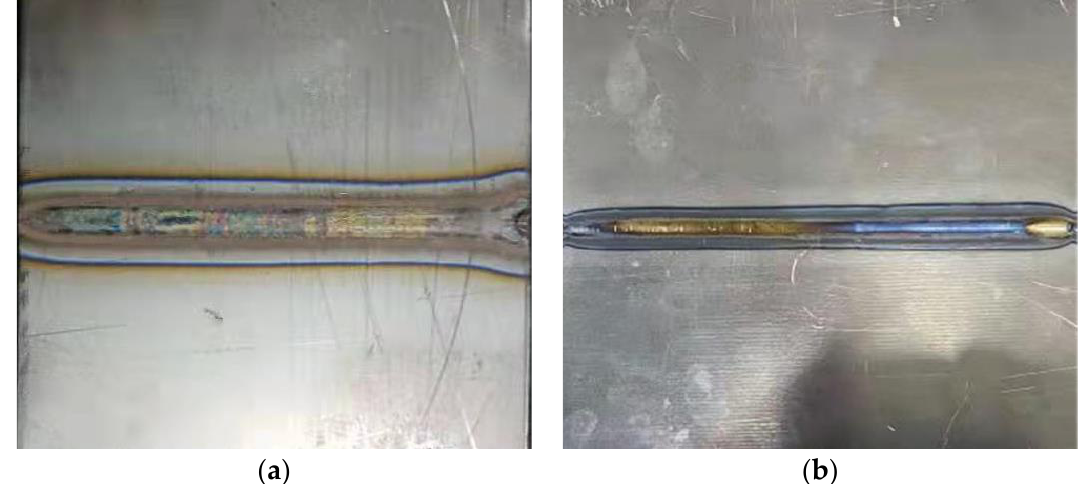
Figure 4. Upper surface appearance of titanium alloy weldment: ( a ) TIG weldment, ( b ) LBW weldment.